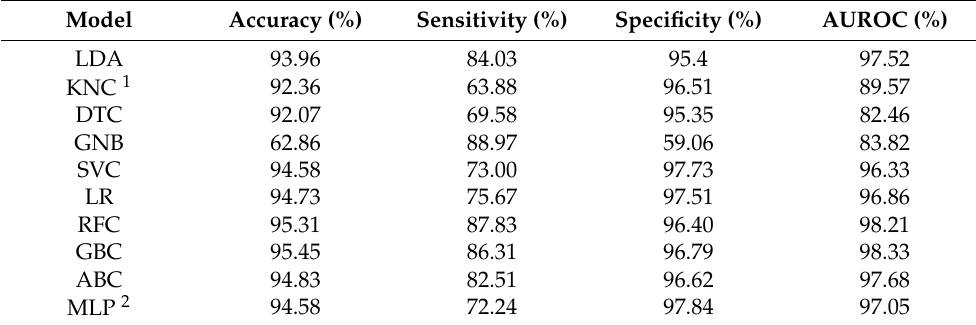
Table 5. Performance of ML models in predicting receiving CABG treatments. Model